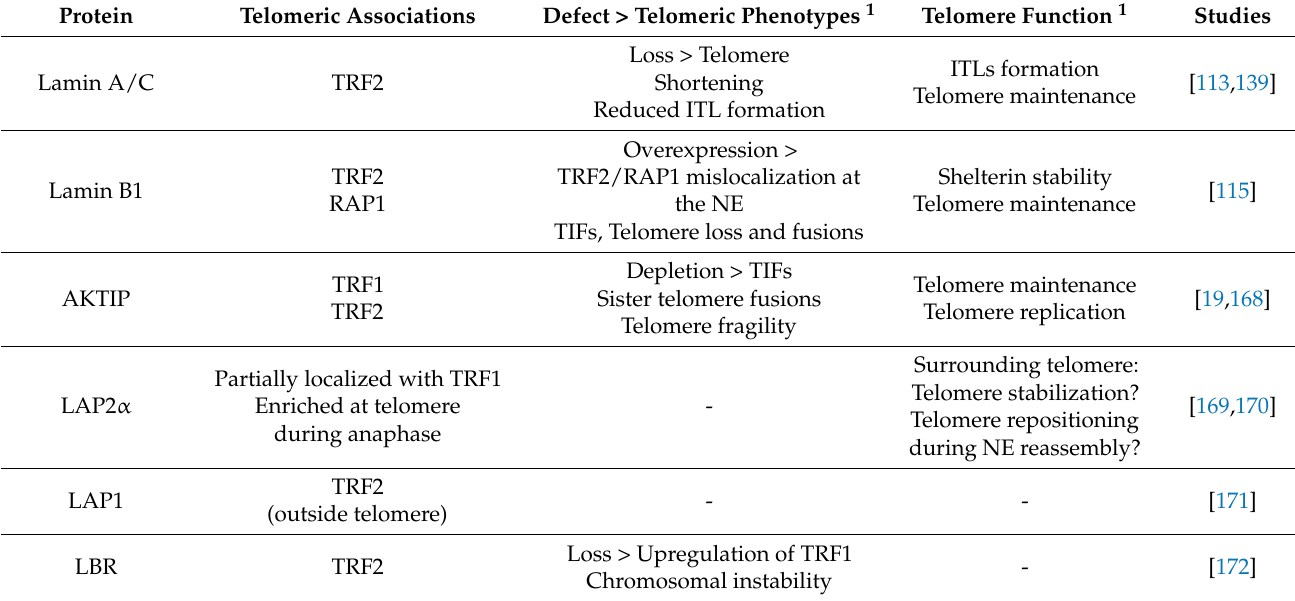
Table 1. Summary of associations between lamins and lamina-associated proteins and telomeric proteins, impact of their alterations on telomeric phenotypes, and their potent functions at the mammalian